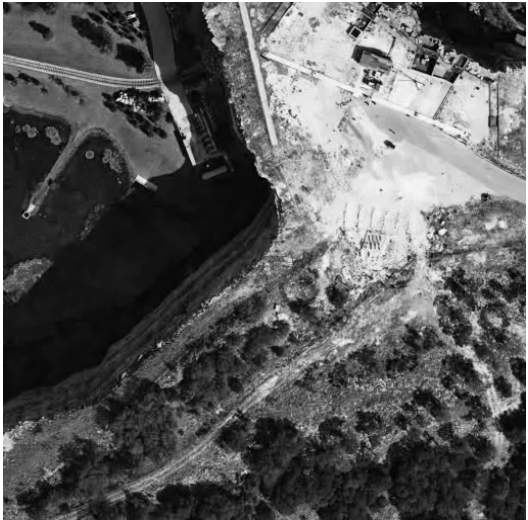
Figure 11. Enlarged fragment of output image for filtering with one ( a ) and two ( b ) nonlinearly transformed references (full images are presented in Figure 10).